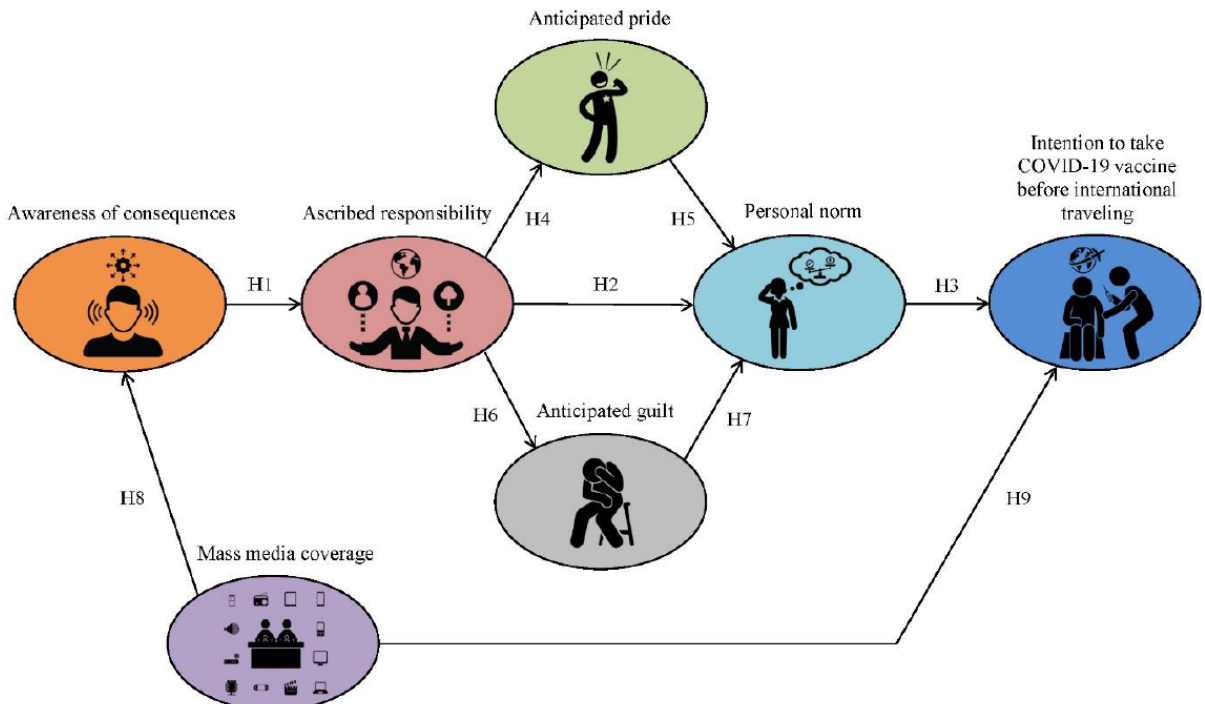
Figure 1. The conceptual model based on extended Norm-Activation Model